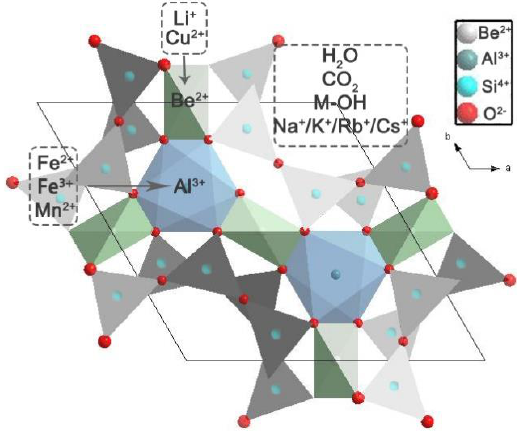
Figure 1. The crystal structure of beryl. Al 3+ can be replaced by Fe 2+ , Fe 3+ , and Mn 2+ ; Be 2+ can be replaced by Li + and Cu 2+ ; H 2 O, CO 2 , alkali ions, and M–OH are present in